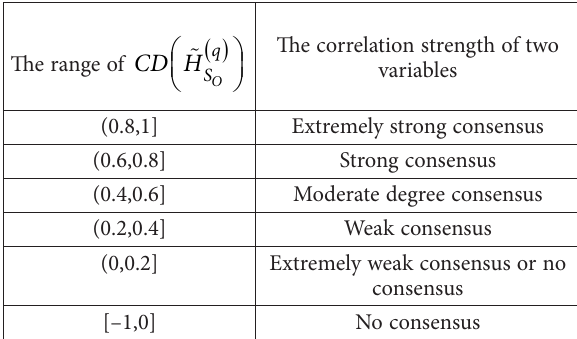
Table 2. The consensus degree of two DHHFLPRs based on the ranges of correlation